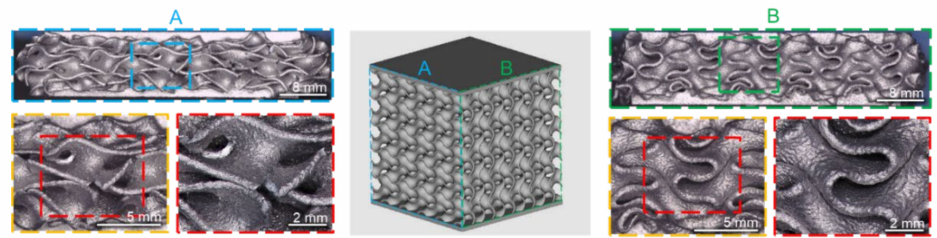
Figure 17. Failure analysis on two surfaces of the diamond TPMS structure for 0.4 mm wall thick- ness/0.13 relative density showing cell